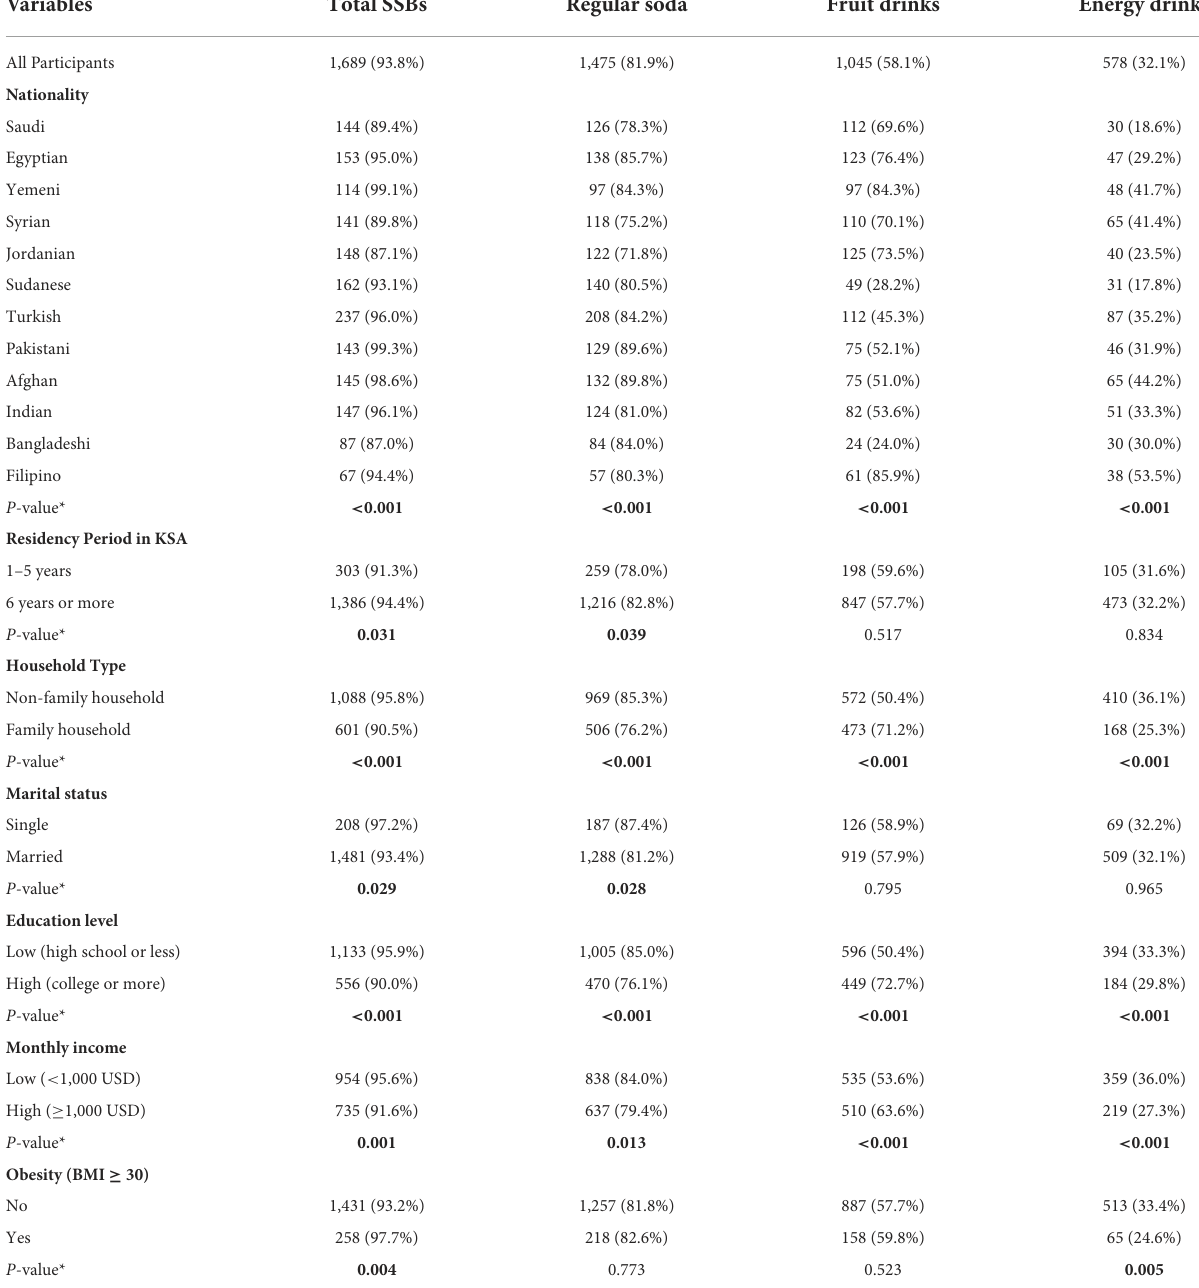
TABLE 1 Prevalence of weekly sugar-sweetened beverages (SSBs) consumption among study participants ( n = 1,800) stratified by sociodemographic variables and obesity. Variables Regular